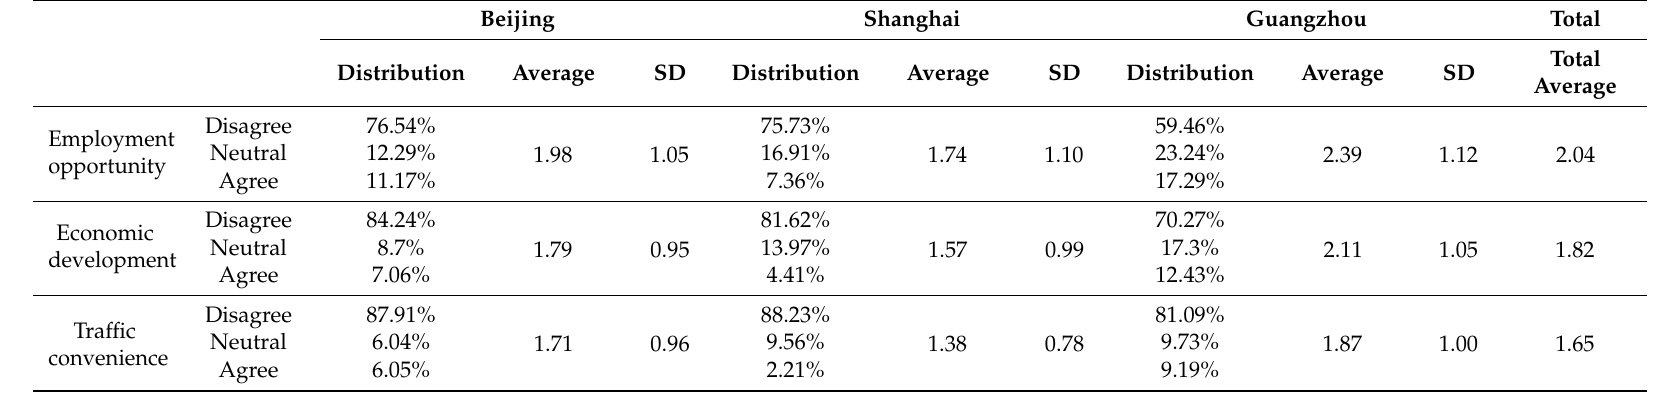
Table 9. Distribution of perceived cost in Beijing, Shanghai, and Guangzhou.